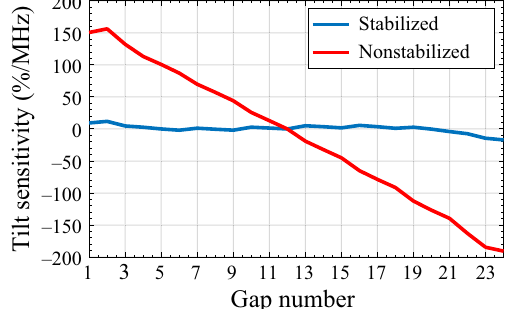
FIG. 17. Tilt sensitivity of stabilized and nonstabilized NIMMS QA-DTL at 4 MV = m.